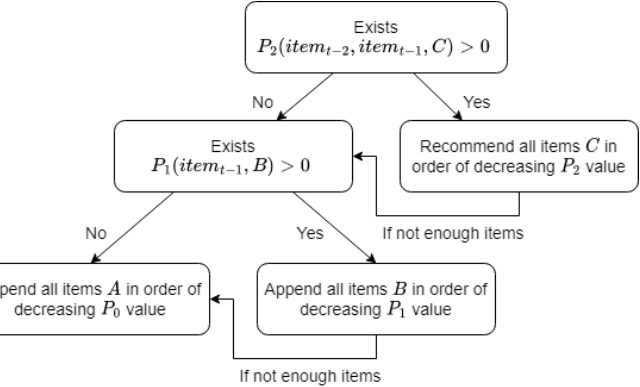
Figure 2. The flowchart of the proposed Hierarchical Sequence Probability (HSP) algorithm. When- ever appending an item in the recommendation list, we make sure it is not already included to avoid duplicate